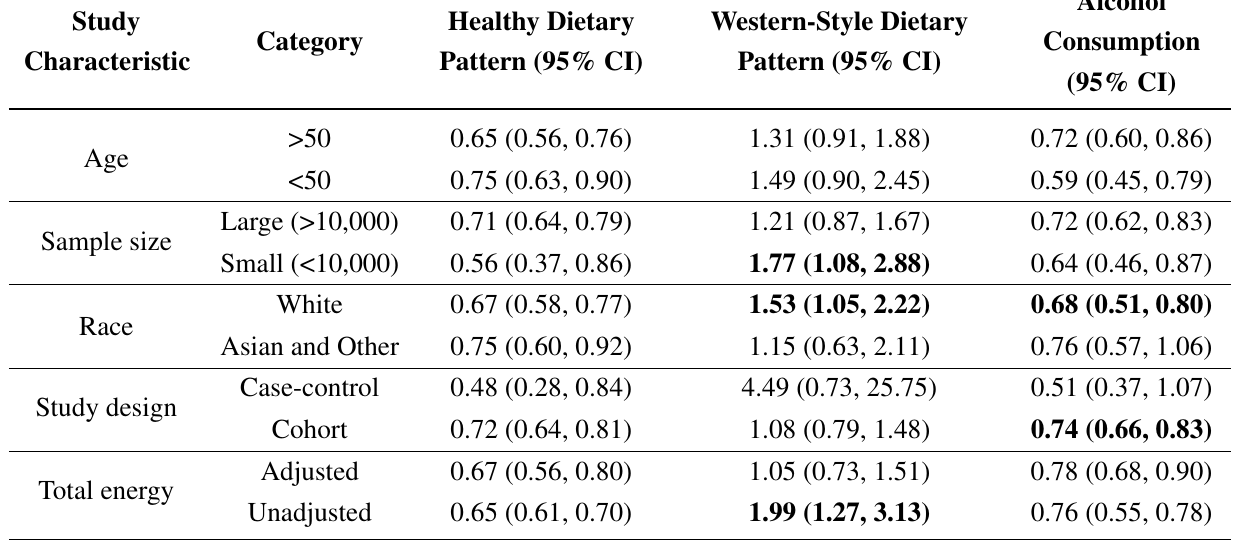
Table B2. Dietary patterns, alcohol consumption and coronary heart disease: sensitivity